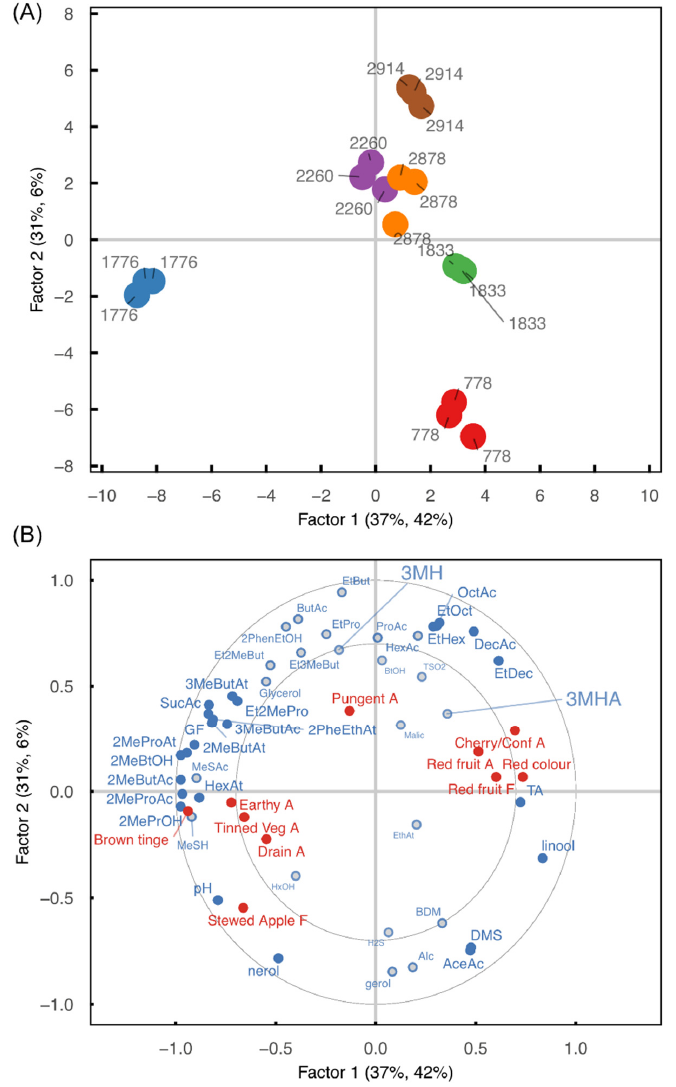
Figure 6. Factor 1 and 2 for the scores ( A ) and loadings ( B ) plots from partial least squares (PLS) regression models for Grenache wines after 9 months generated using important sensory attributes (Y variables, red) and compositional compounds (X variables, blue) for each fermentation replicate of the winemaking treatments (yeast strains). Compounds significant to each PLS model are indicated by filled blue circles, and compounds with a lesser contribution to the model are shown as open circles and with smaller text. The proportion of the X variance explained by the two factors is denoted by the first value in parentheses, the proportion of Y variance by the second value. Chemical composition and labels are summarised in Table S8. A, aroma attributes; F, flavour attributes. Both thiols 3-MH and 3-MHA are highlighted in the figure with larger text. The appearance terms were relatively well modelled ( red colour intensity R 2 calibra- tion = 0.55, validation = 0.45; and brown tinge R 2 calibration = 0.89, R 2 validation = 0.84), and were associated with pH differences between wines. Of the aroma and palate at- tributes modelled, only cherry/confectionary aroma (R 2 calibration = 0.57, R 2 validation = 0.44) and stewed apple/port-like flavour (R 2 calibration = 0.74, R 2 validation = 0.59) were well modelled. For cherry/confectionary aroma , 3-MH and 3-MHA had relatively high posi- tive regression coefficients of β w = 0.026 and β w = 0.031, respectively (Figure 7a).